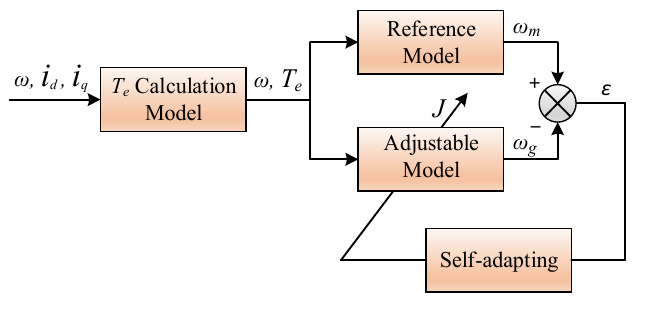
Figure 3. Block diagram of MRAS.